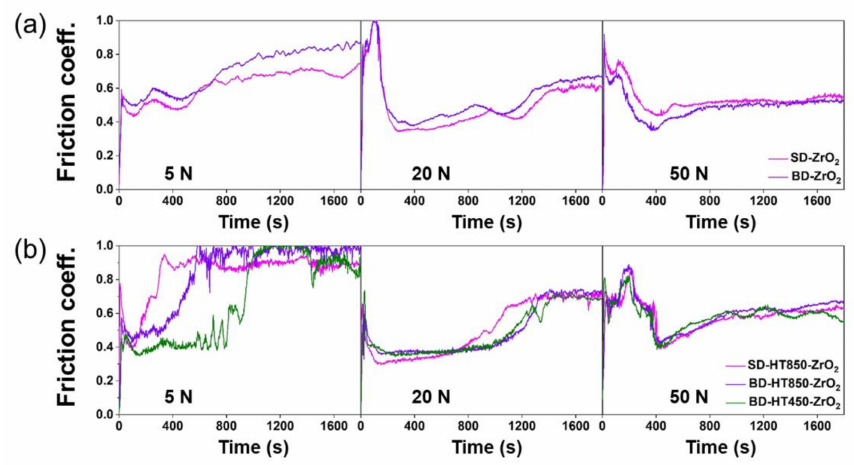
Figure 12. Evolutions of COF with time during the wear test using ZrO 2 ball as counterpart material: ( a ) as-built and ( b ) heat-treated